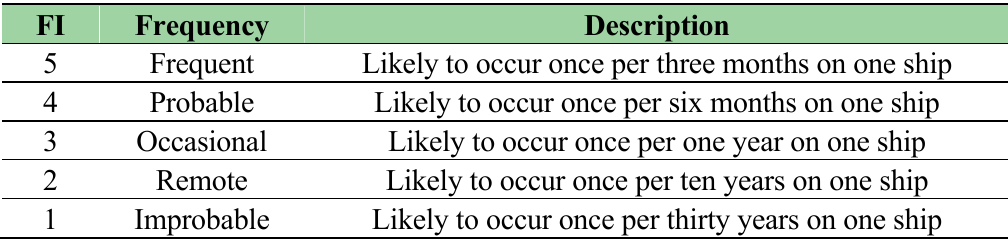
Table 4. Definitions for the frequency index table for